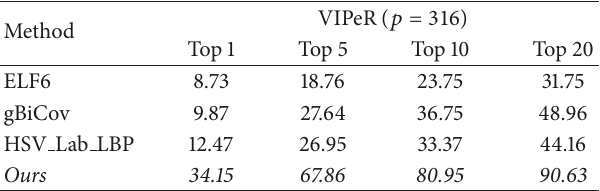
Table 2: Comparison of state-of-the-art results of feature repre- sentation reported with VIPeR database. The cumulative matching scores (%) at ranks 1, 5, 10, and 20 are listed.